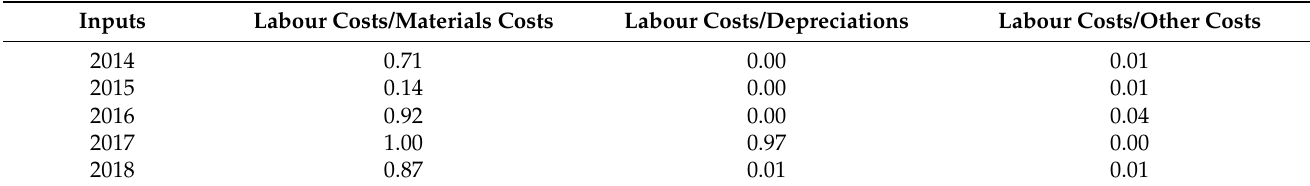
Table 5. p -values for Shapiro-Wilk test for normality, H0–distribution is normal.